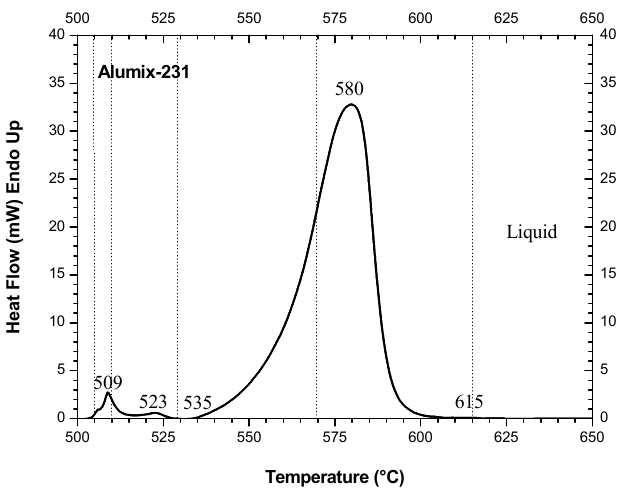
Figure 1. DSC curve of the green pellet of neat